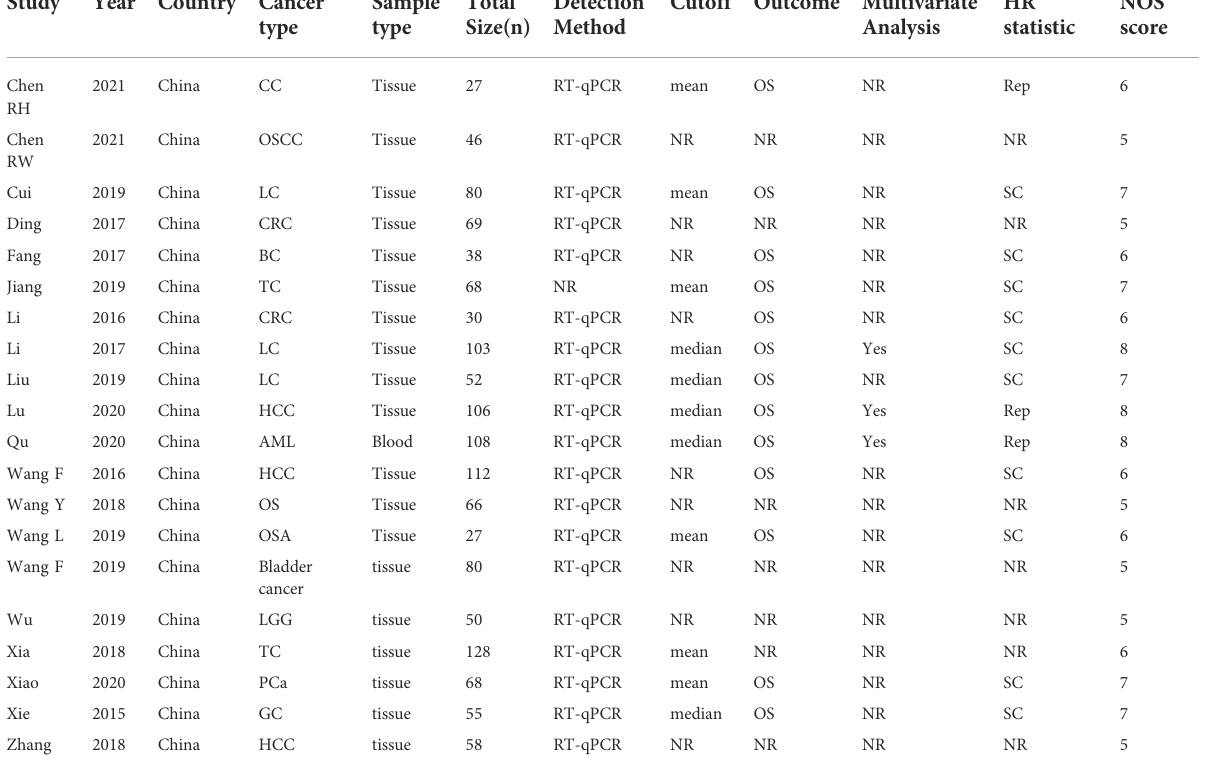
TABLE 1 Characteristics of studies in this